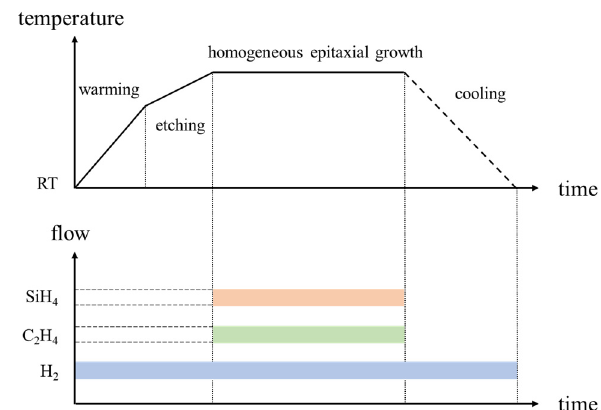
Figure 1. Schematic diagram of the experimental process of 4H-SiC epitaxy.